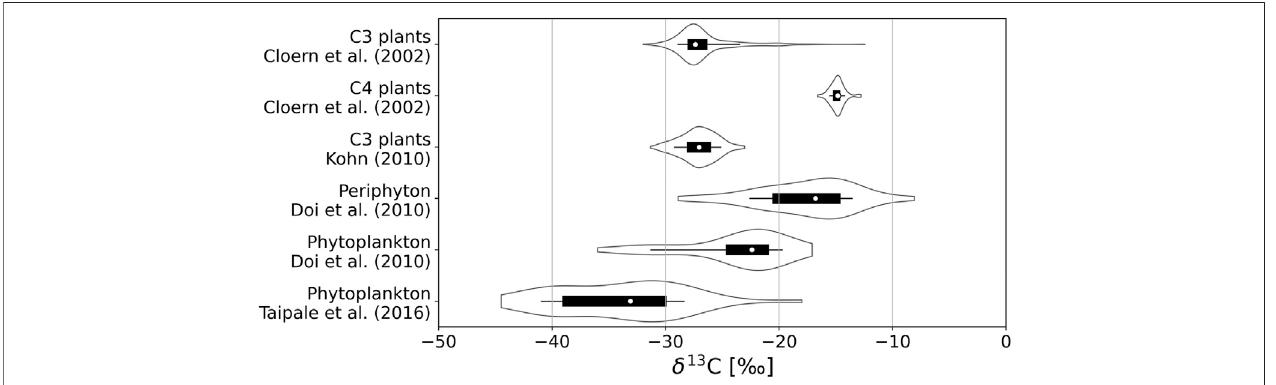
FIGURE 1 | Ranges of δ 13 C values observed in C3 and C4 plants, in phytoplankton and in benthic algae (periphyton) in previous studies. In each distribution, the white dot indicates the median, the thick black bar indicates the interquartile range, the thin black line indicates the range of values between the 10- and 90-percentiles, and the wavy curves indicate the Gaussian kernel density estimate of the distribution of